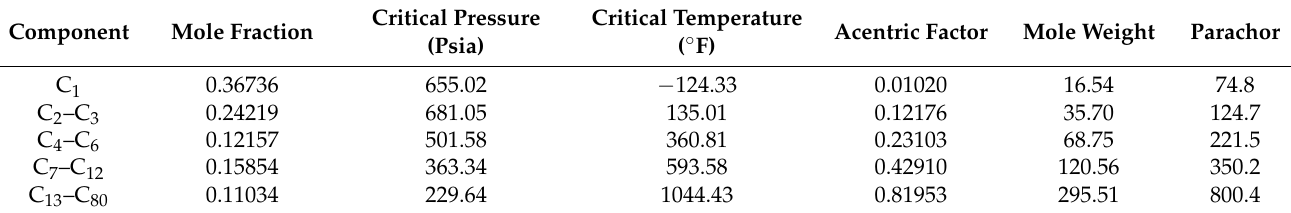
Table 1. Mole fraction and basic properties of studied fluid [34].